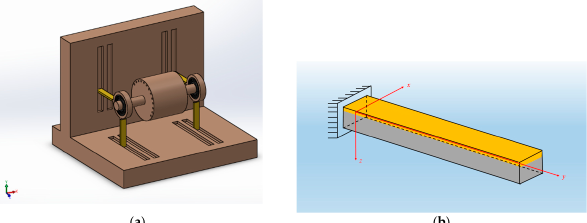
Figure 1. ( a ) Ferroelectric rotor–piezoelectric supports (yellow) system with ball bearings (black) on the fixed base, as realized in SolidWorks; ( b ) Piezoelectric support scheme with the local coordinate system (yellow layer: PZT, grey layer: steel).